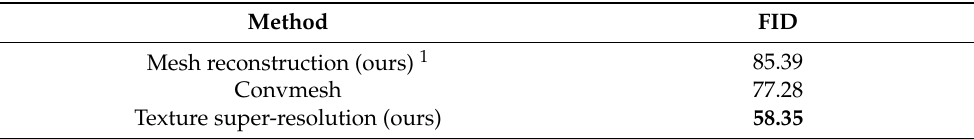
Table 2. The quantitative comparison results of texture